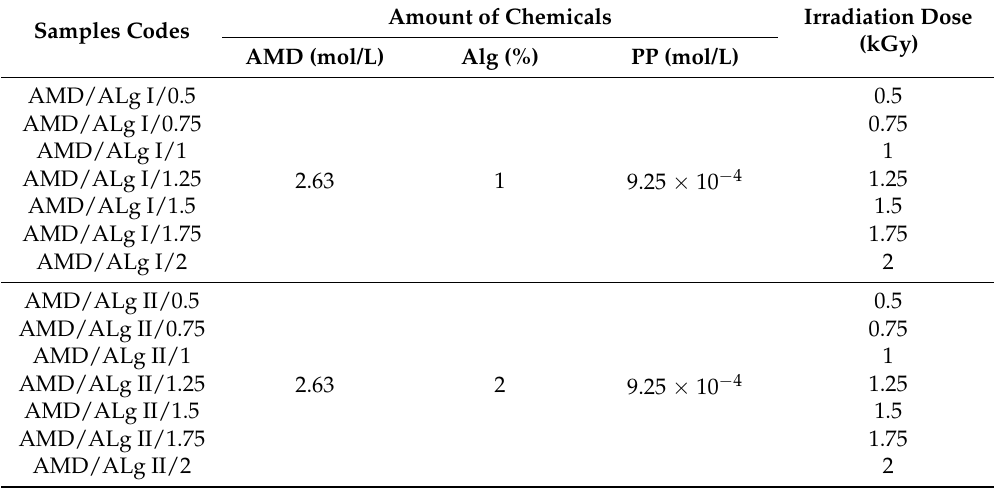
Table 2. The polyelectrolytes synthesis details.